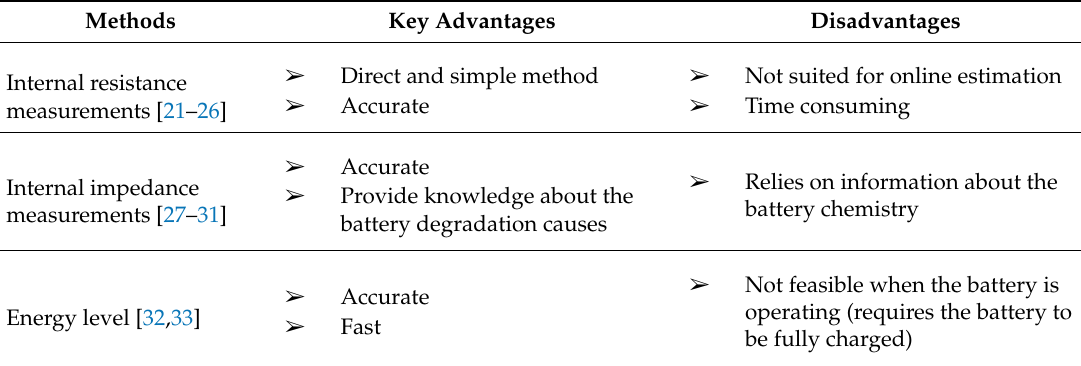
Table 1. Experimental-based